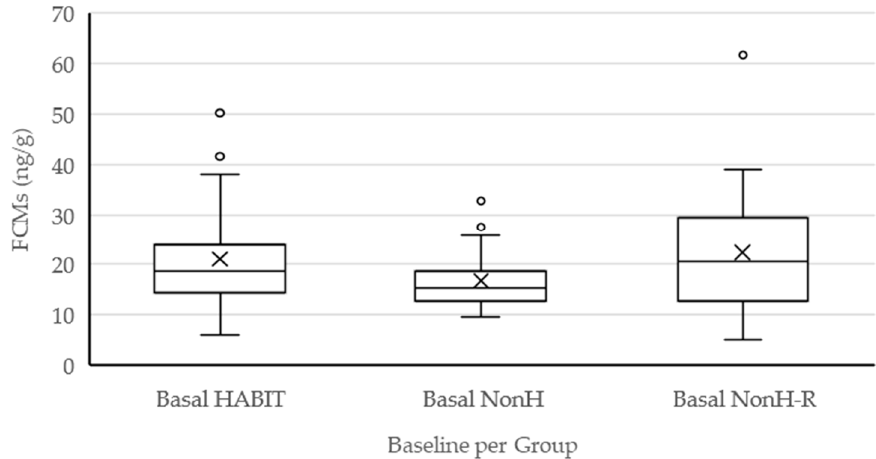
Figure 5. Boxplot graphs (bold line: median; cross: mean value; boxes: first and third quartile; whiskers: 5th and 95th percentiles; circles: outlier values) of baseline FCM concentrations (ng/g) per group.